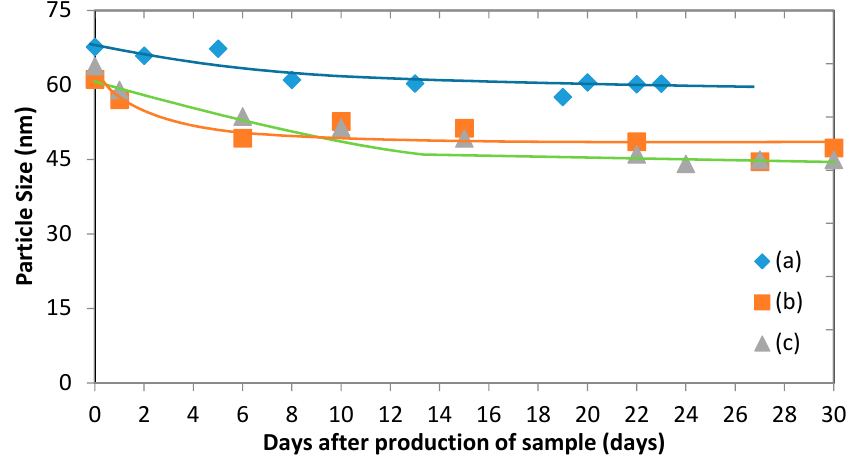
Figure 11. ( a ) The change in average particle size of micelles during storage: ( a ) Drug-free micelles produced in microfluidic device at Q a = 5 mL·h − 1 and Q o = 0.71 mL·h − 1 . The organic phase was 1 mg·mL − 1 PEG- b -PCL (B) in THF; ( b ) Drug-loaded micelles produced using membrane device. The fluconazole content in the organic phase was 0.4 mg·mL − 1 per 1 mg·mL − 1 PEG- b -PCL (A); ( c ) Drug-loaded micelles produced using membrane device. The fluconazole content in the organic phase was 0.4 mg·mL − 1 per 1 mg·mL − 1 PEG- b -PCL (B).